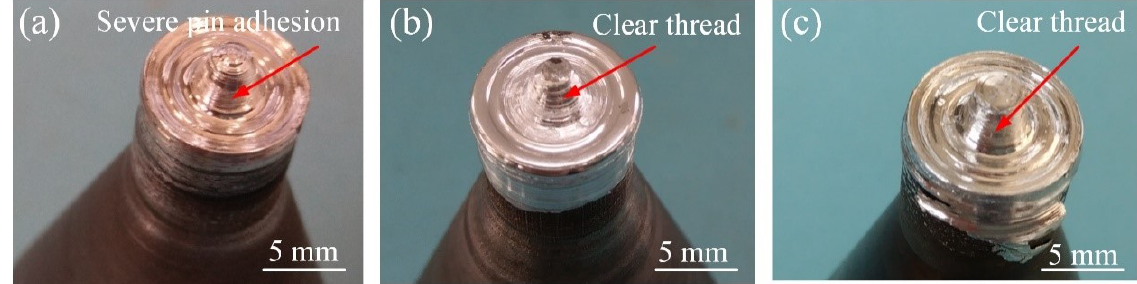
Figure 2: Morphologies of rotational tool after welding based on stationary shoulder process at typical welding speeds: (a) 30 mm/min, (b) 60 mm/min and (c) 80 mm/min